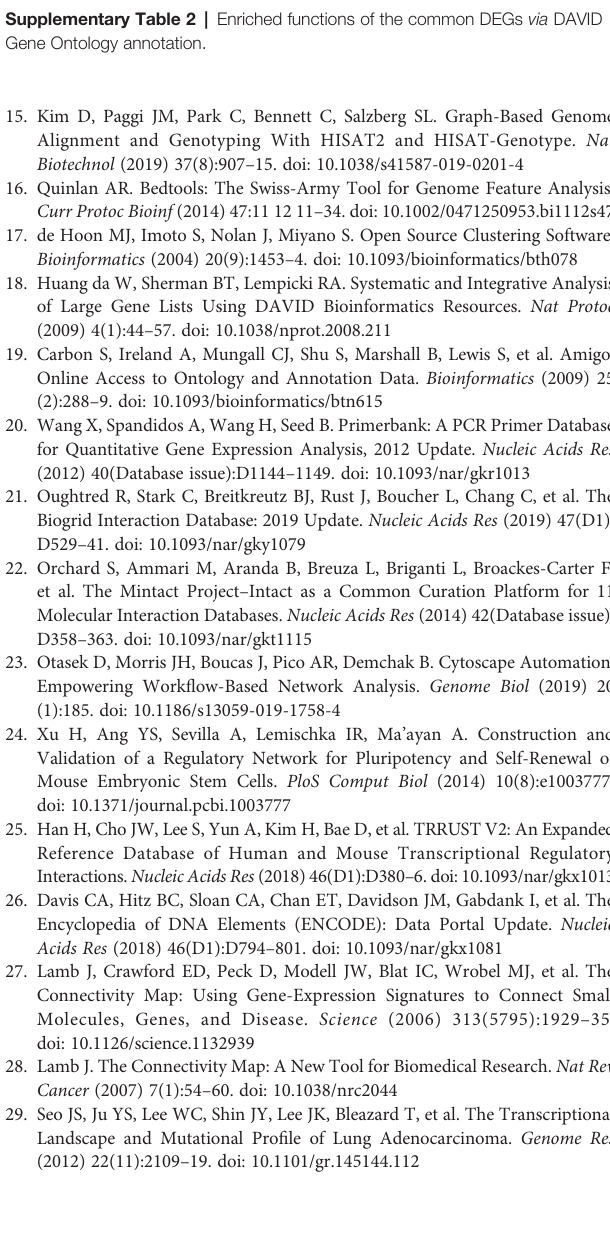
Supplementary Figure 1 | The heatmap of DEGs involved in the cell cycle. All DEGs with the absolute FC of ≥ 2.0 and p-value of ≤ 0.05 were showed. Supplementary Figure 2 | The heatmap of DEGs involved in cell division. All DEGs with the absolute FC of ≥ 2.0 and p-value of ≤ 0.05 were showed. Supplementary Figure 3 | The heatmap of DEGs involved in cell proliferation. All DEGs with the absolute FC of ≥ 2.0 and p-value of ≤ 0.05 were showed. Supplementary Table 1 | List of the common DEGs in both patient tissues and cell lines between human lung cancer cells and adjacent lung normal cells. Supplementary Table 2 | Enriched functions of the common DEGs via DAVID Gene Ontology